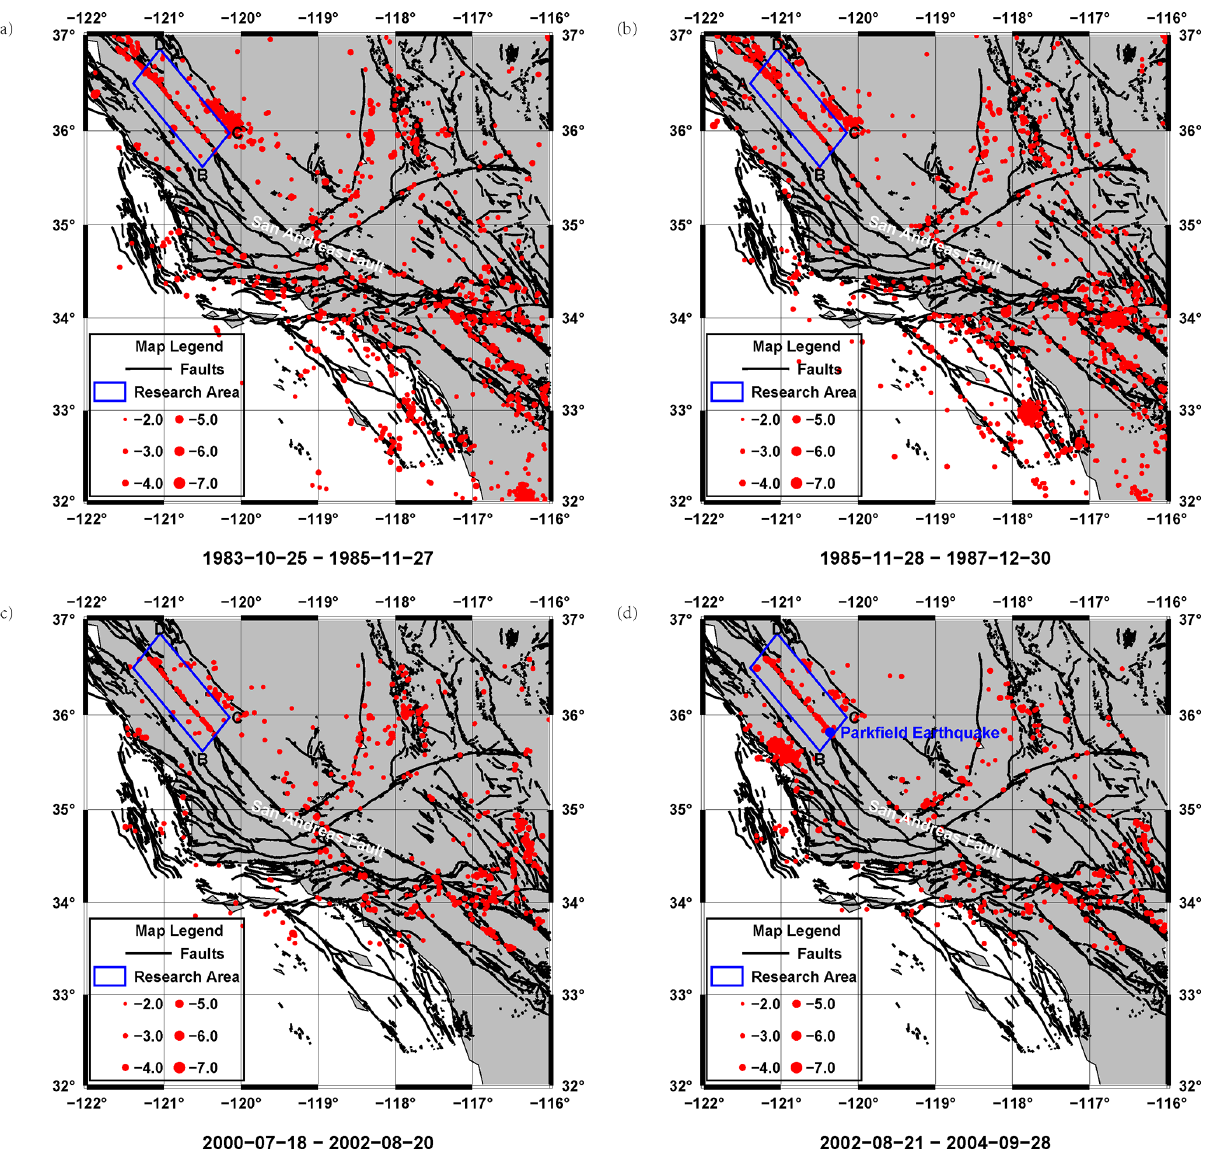
Figure 5. The seismicity of the research area and surrounding area in a seismic cycle. The red points indicate the epicenters of earthquakes in the corresponding time. The location of the San Andreas Fault and the epicenter of the Parkfield earthquake are indicated on the map by white and blue fonts, respectively. The corresponding time is shown under each image. (a) Seismicity during 25 October 1983 to 27 November 1985. (b) Seismicity during 28 November 1985 to 30 December 1987. (c) Seismicity of the research area and surrounding area during 18 July 2000 to 20 August 2002. (d) Seismicity of the research area and surrounding area during 21 August 2002 to 28 September